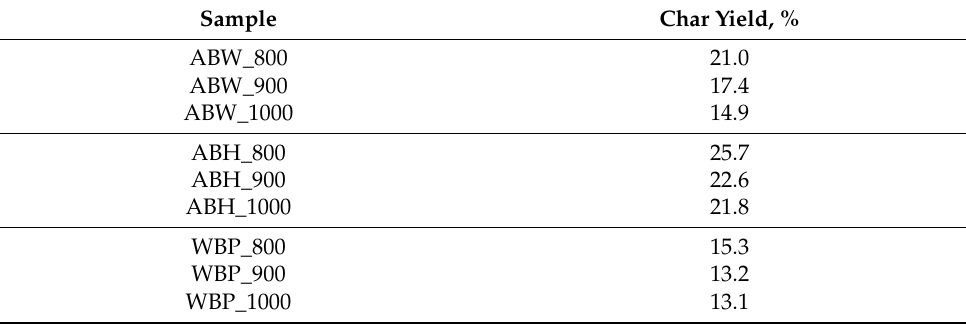
Table 3. The yield of char formation during